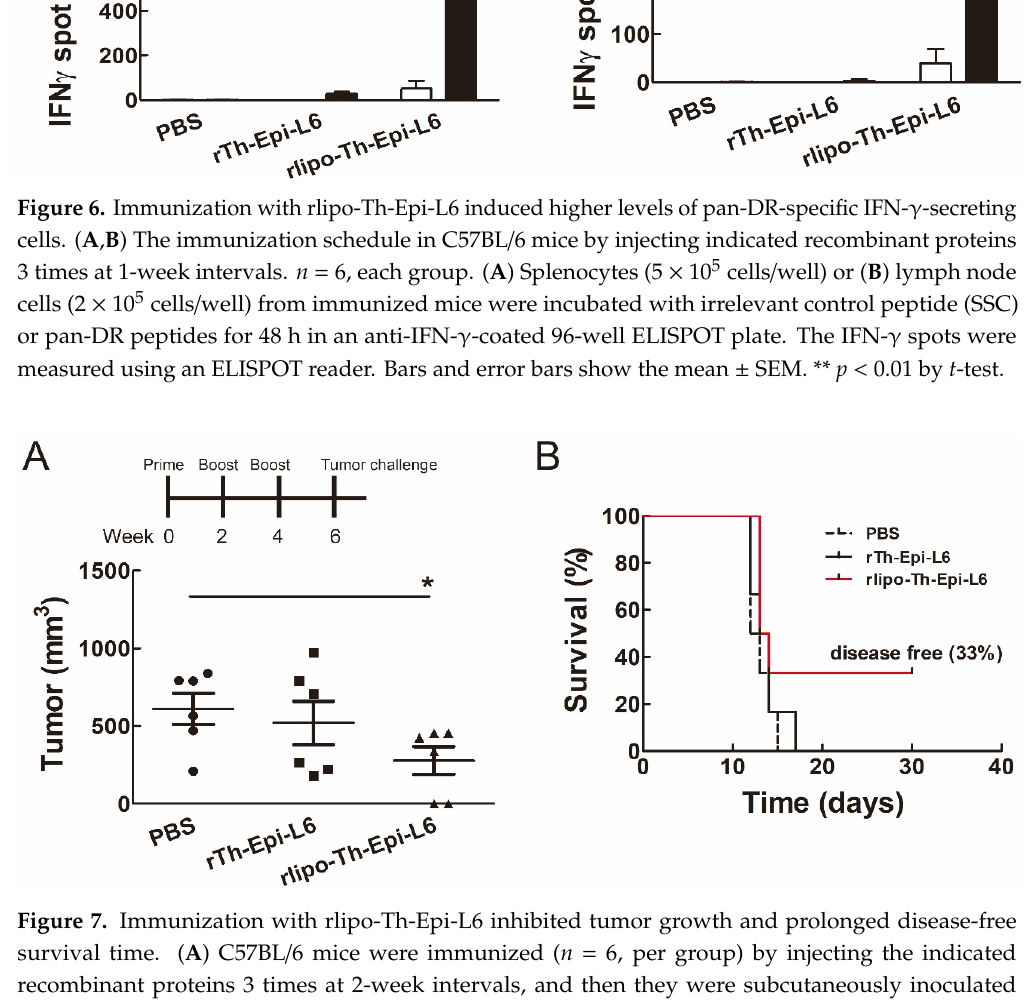
Figure 6. Immunization with rlipo ‐ Th ‐ Epi ‐ L6 induced higher levels of pan ‐ DR ‐ specific IFN ‐γ‐ secreting cells. ( A , B ) The immunization schedule in C57BL/6 mice by injecting indicated recombinant proteins 3 times at 1 ‐ week intervals. n = 6, each group. ( A ) Splenocytes (5 × 10 5 cells/well) or ( B ) lymph node cells (2 × 10 5 cells/well) from immunized mice were incubated with irrelevant control peptide (SSC) or pan ‐ DR peptides for 48 h in an anti ‐ IFN ‐γ‐ coated 96 ‐ well ELISPOT plate. The IFN ‐γ spots were measured using an ELISPOT reader. Bars and error bars show the mean ± SEM. ** p < 0.01 by t ‐ test.